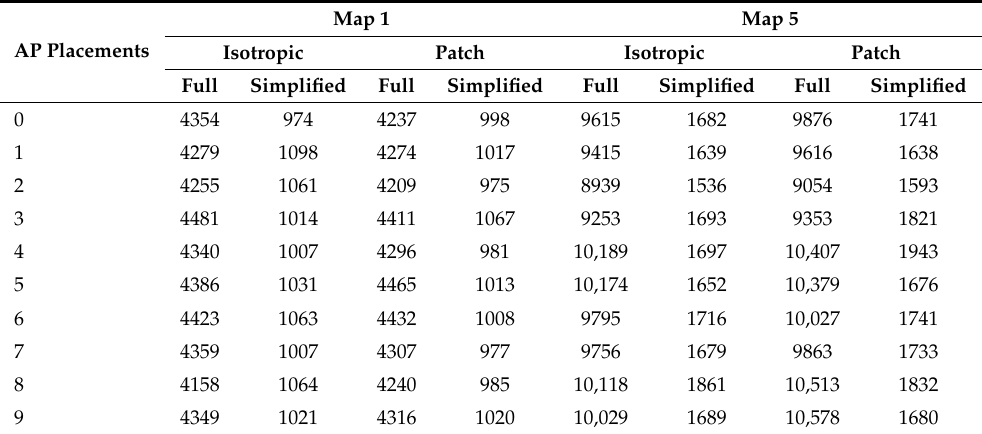
Figure 10 illustrates the simplified coverage regions for the five maps, generated as follows. The data of a selected region is exported from OpenStreetMap. The RTS is used to generate the coverage region, adding 2 m’s padding around each map for easier processing of the buildings on the map. Then we keep 3 m’s margin between the borders of the map and the coverage region.